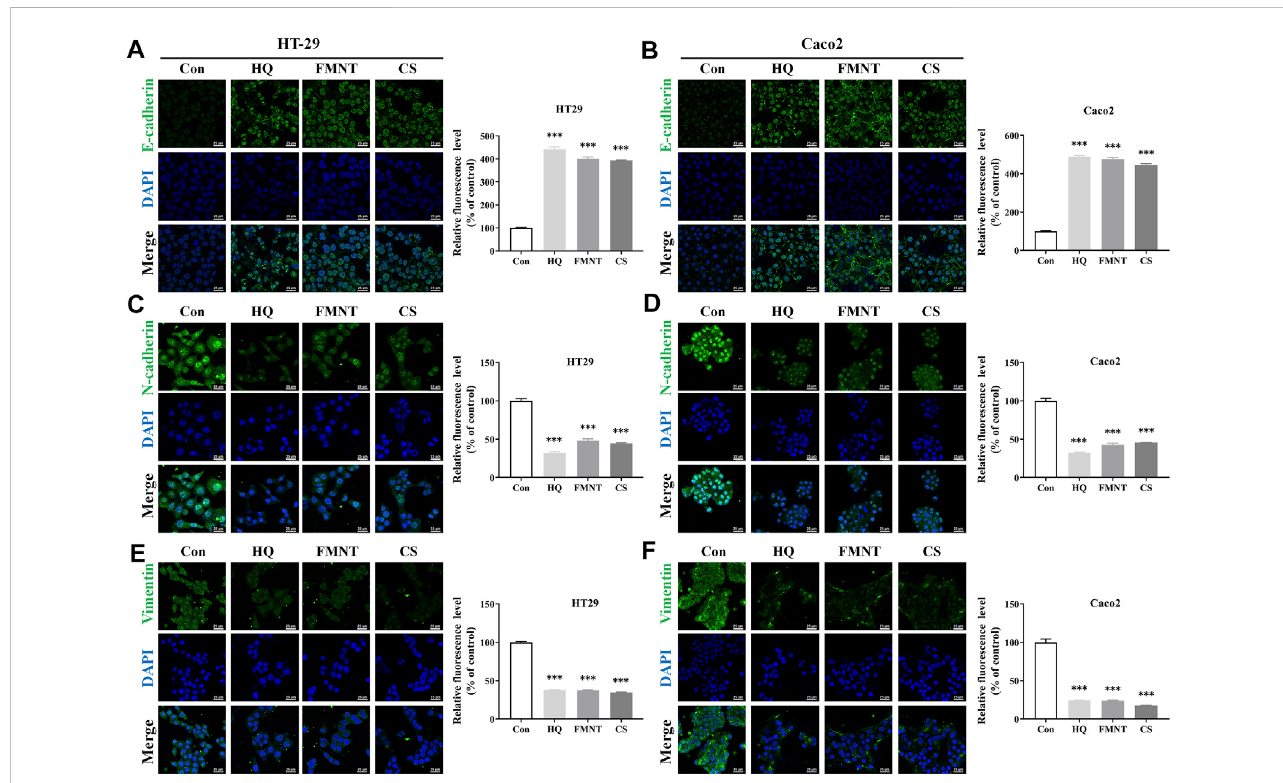
FIGURE 10 HQ, FMNT and CS signi fi cantly increased the fl uorescence intensity of E-cadherin (A, B) , and decreased the fl uorescence intensity of N-cadherin (C, D) andVimentin (E,F) inHT29andCaco2cells.The fl uorescenceintensity ofE-cadherin,N-cadherin,andVimentininHT29andCaco2cellsweredetectedafter treatment with HQ (100 mg/mL, 48 h), FMNT (100 μ M, 48 h) or CS (100 μ M, 48 h), respectively. The data represent the mean ± SD ( n = 3). *** p < 0.001 compared with the control